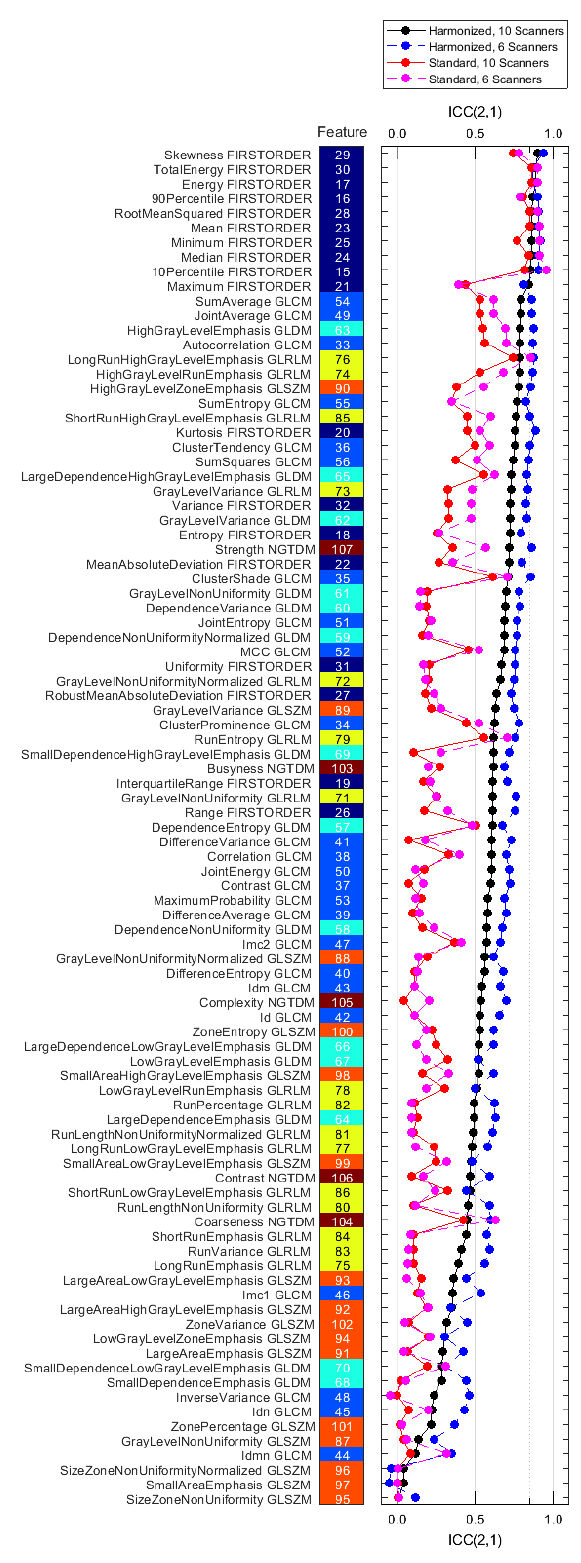
Figure 4. ICC(2,1) values for all features for the reproducibility datasets S10, H10, S6, and H6 (Table 4), ranked by decreasing value of the H10 dataset (solid black). The feature class of each feature is indicated by the color of the tiles (dark blue: first order, light blue: GLCM, cyan: GLDM, yellow: GLRLM, orange: GLSZM, brown: NGTDM).